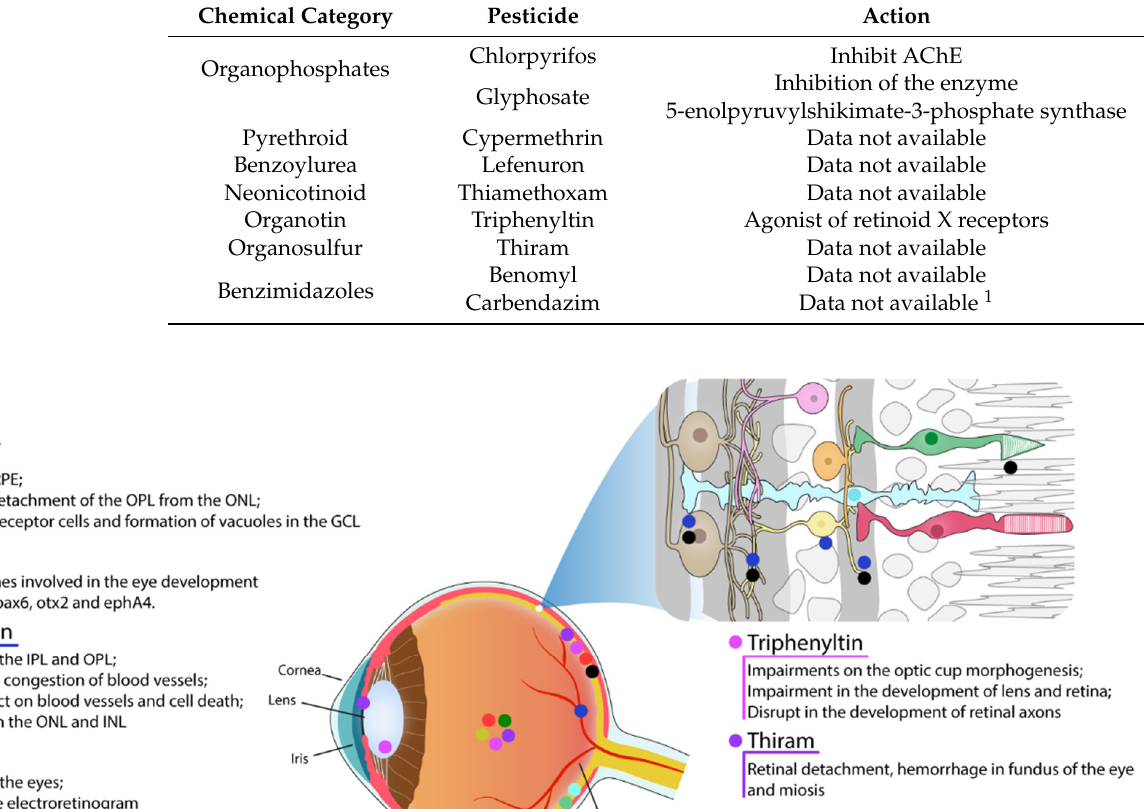
Table 1. Pesticides and their actions.